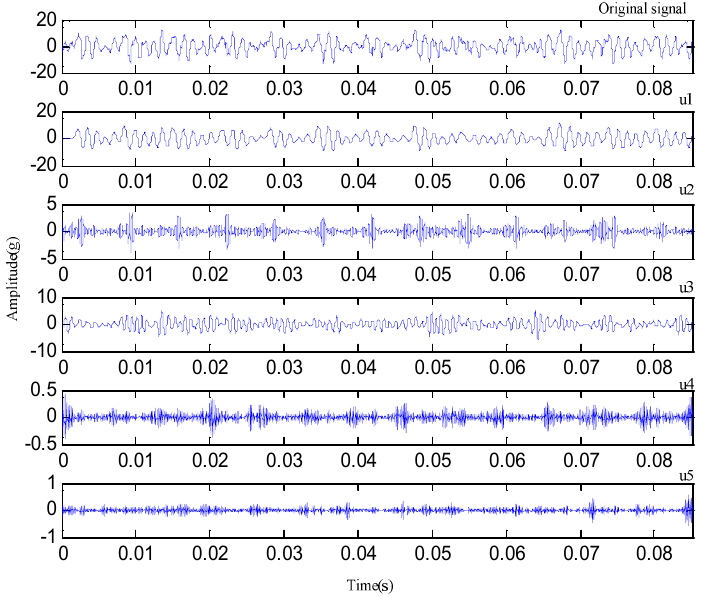
Figure 14. Test signal and decomposition results by FE-guided VMD.